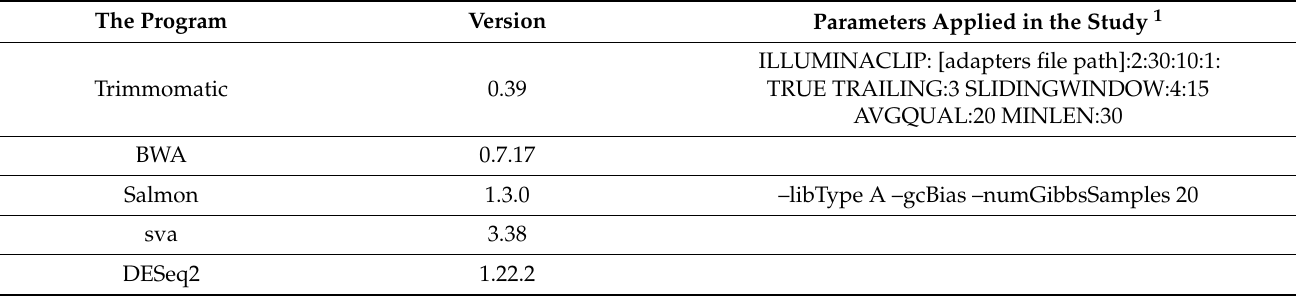
Table 1. Programs and parameters for read